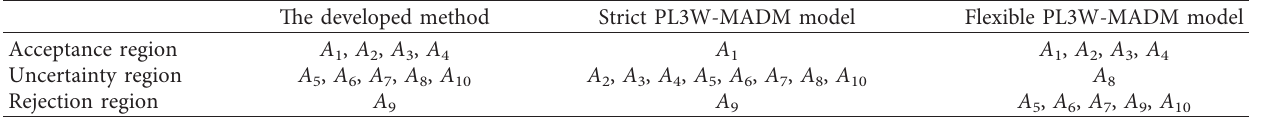
Table 9: The comparative analysis of the developed hidden property evaluation method and other methods.